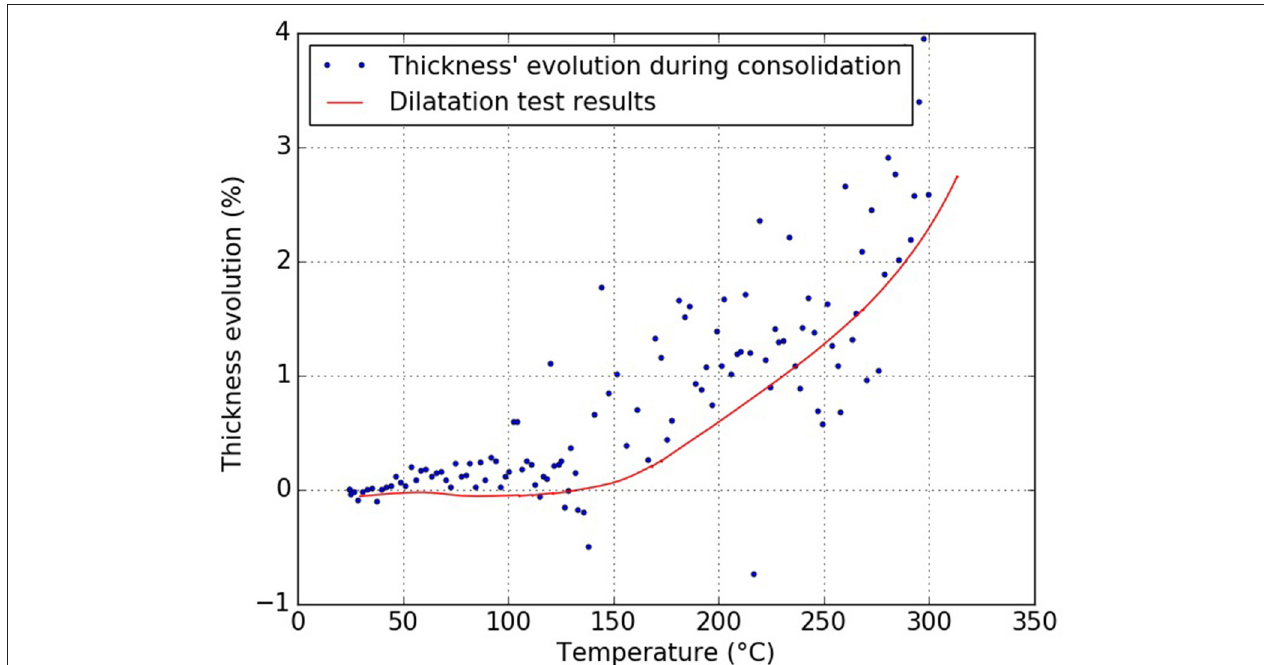
FIGURE 7 | Comparison between thermal expansion and laminate thickness results.